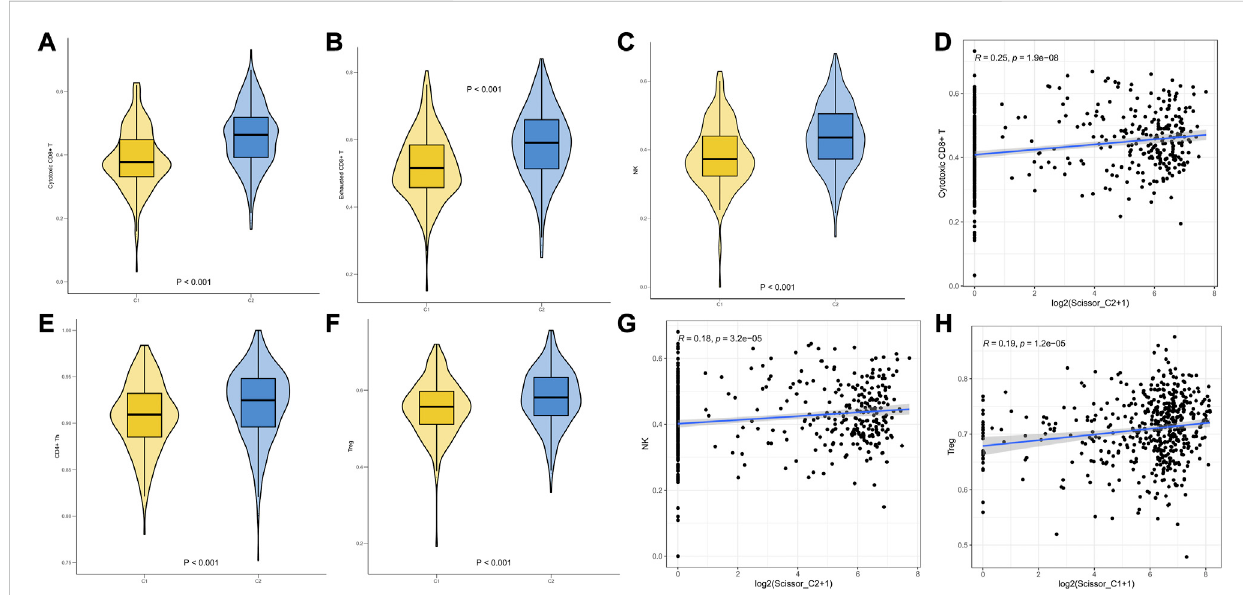
FIGURE 7 (A – F) ssGSEAin fi ltrationscoresofT-cellsintwogroupsofimmunesubtypes.( D,G,H